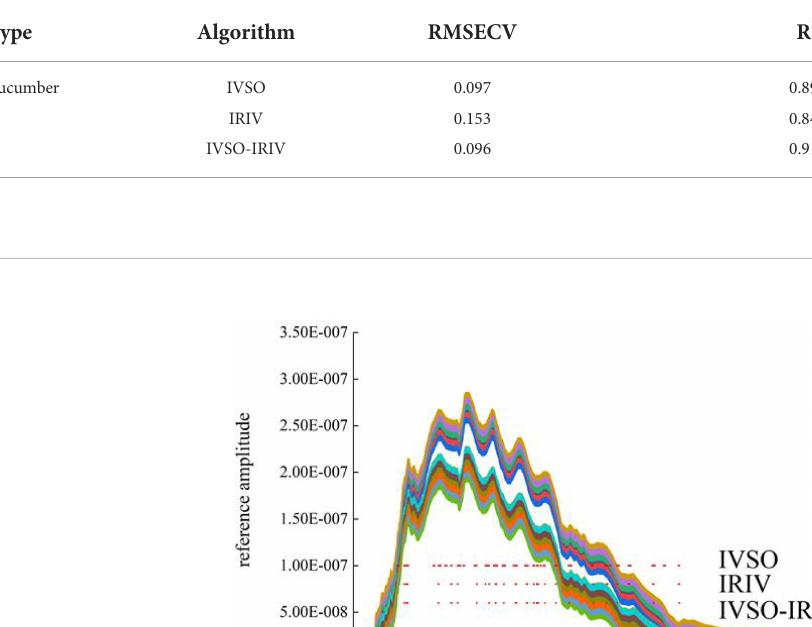
TABLE 6 Comparison of model results for terahertz feature wavelength